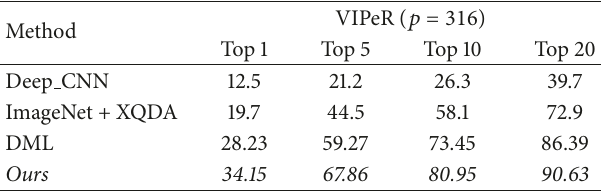
Table 8: Comparison of CNN-based algorithms results reported with VIPeR database. The cumulative matching scores (%) at ranks 1, 5, 10, and 20 are listed.